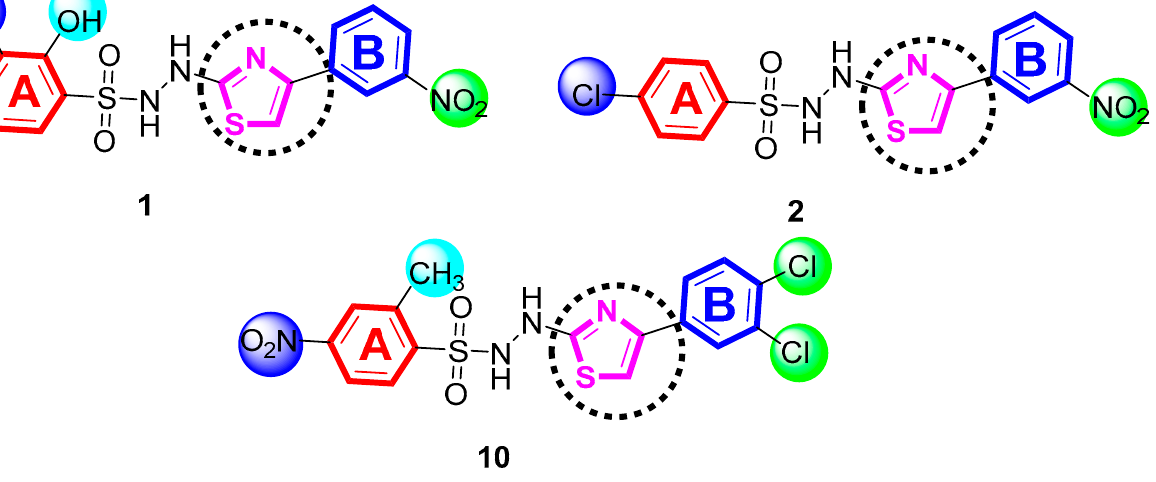
Figure 8. SAR study for scaffolds 1 , 2 , and 10 .